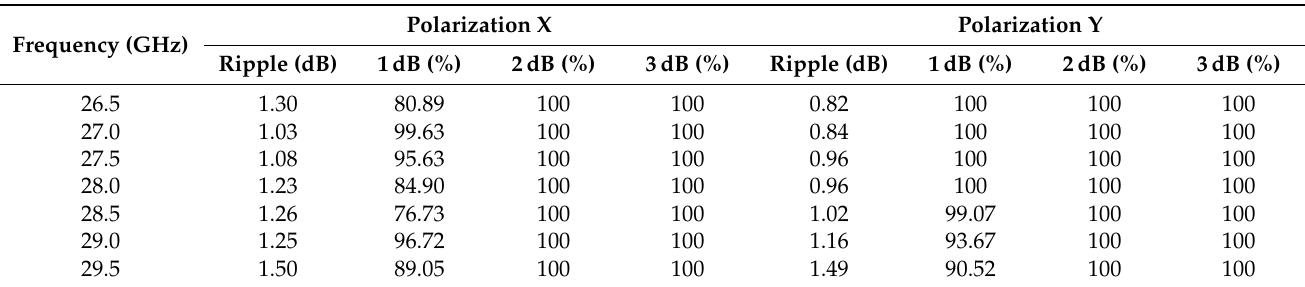
Table 4. Performance of the optimized layout in the whole 5G NR n257 band. XdB (%) indicates what percentage of the coverage area complies with a ripple of